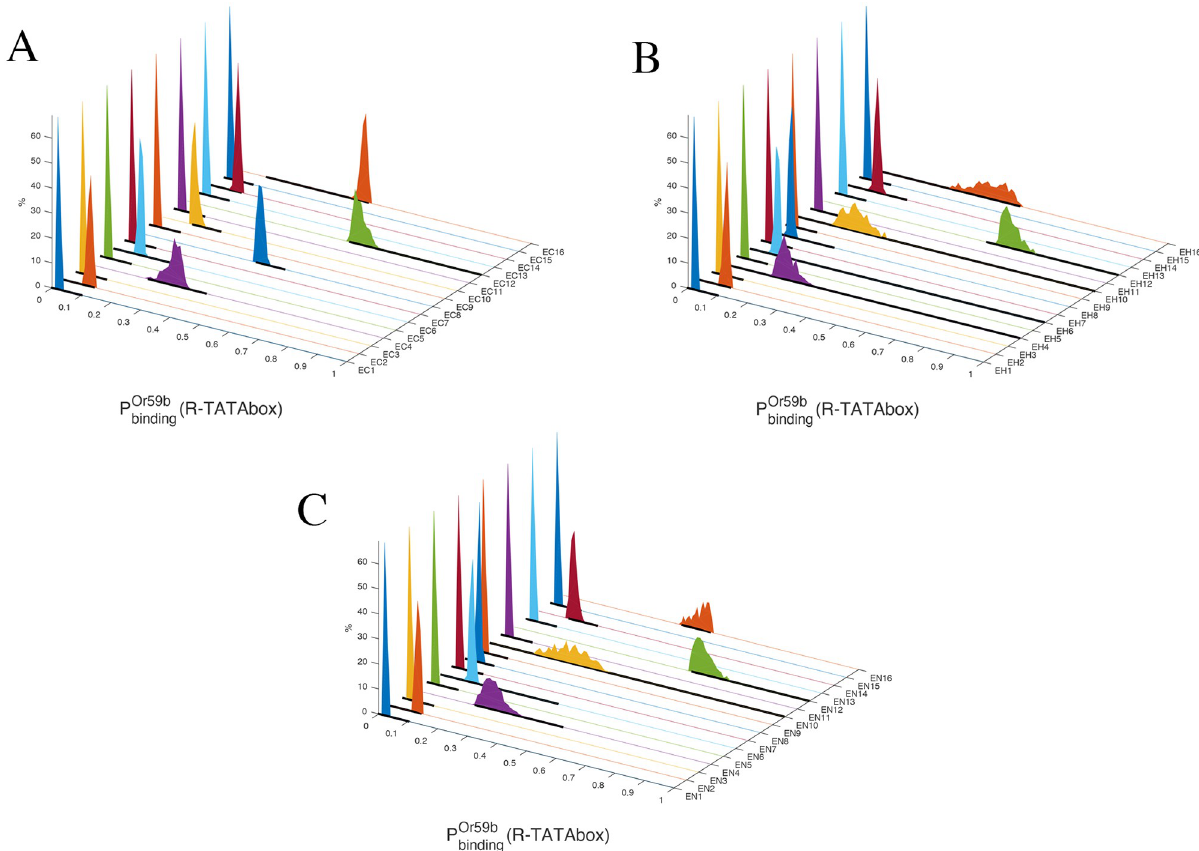
Fig 2. (A): Probability distribution of RNAp binding (i.e., P Or 59 b ð R (cid:0) TATAbox Þ ) for the normal (“closed”) chromatin case (column C of Table 1) in binding the 16 mutations of the truth table (Table 1). The horizontal black lines represent the admissible expression intervals of the gene, as reported in Table 1 and Fig 1(B). The histograms show only the samples which respect all constraints. (B): P Or 59 b ð R (cid:0) TATAbox Þ for the heterozygous mutant su(var)3-9 binding ð R (cid:0) TATAbox Þ for the homozygous mutant su(var)3-9 “more open chromatin” case “open chromatin” case (column H of Table 1). (C): P Or 59 b binding (column N of Table 1). See also Fig 3 for a specific sample realization from these